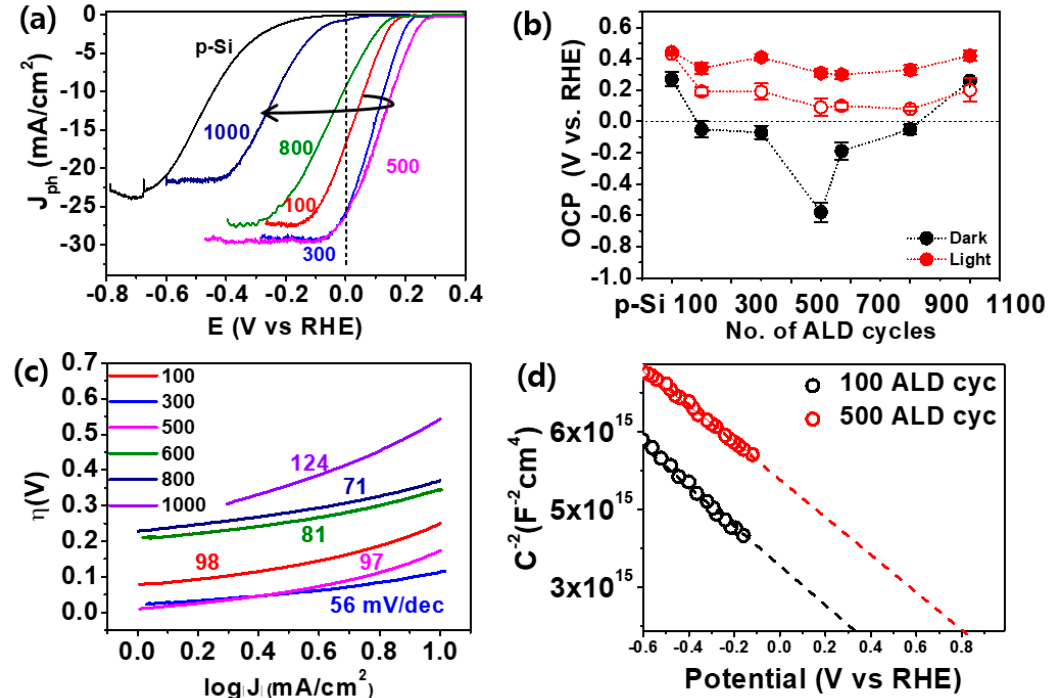
Figure 3. PEC performance of p -Si/SiO x /MoS 2 photocathodes with different numbers of ALD Cycles. ( a ) Current density ( J ph )—voltage (V) characteristic of the photocathodes under 1 sun illumination at a reverse bias. Anodic shifts of up to 0.35 V for the onset voltage (photocurrent onset of 0.1 mA · cm − 2 ) were observed at approximately 500 cycles of ALD with a J ph of ~30 mA · cm − 2 . ( b ) Open circuit potential (OCP) measurement of our simple p -Si/SiO x /MoS 2 photocathode for different MoS 2 thicknesses in the electrolyte. Each sample’s OCP was recorded under dark and with 1 sun illumination. Red and black closed circles represent illumination and dark equilibrium, respectively. Red open circles are saturated voltages. The OCP shifted from positive to negative upon illumination, indicating the p -type property of the substrate. As the thickness increased, the flat-band potential increased from 0.11 ± 0.02 V ( p -Si), and the maximum was obtained at 500 cycles for MoS 2 , which was 0.8 to 0.67 V, as highlighted in the blue shadow. ( c ) Tafel curves of p -Si/SiO x /MoS 2 of different number of ALD cycles. ( d ) Mott-Schottky plots of the p -Si/SiO x /MoS 2 photocathode measured at reverse biases with a frequency of 200 kHz and a scan rate of 10 mV · s − 1 . The effective barrier heights of ~0.8 and 0.4 eV were estimated for 500 and 100 cycles, respectively. Table 1. Summary of V ph , V on , J sc , and J ph of J - V characteristics, as shown in Figure 3. p-Si